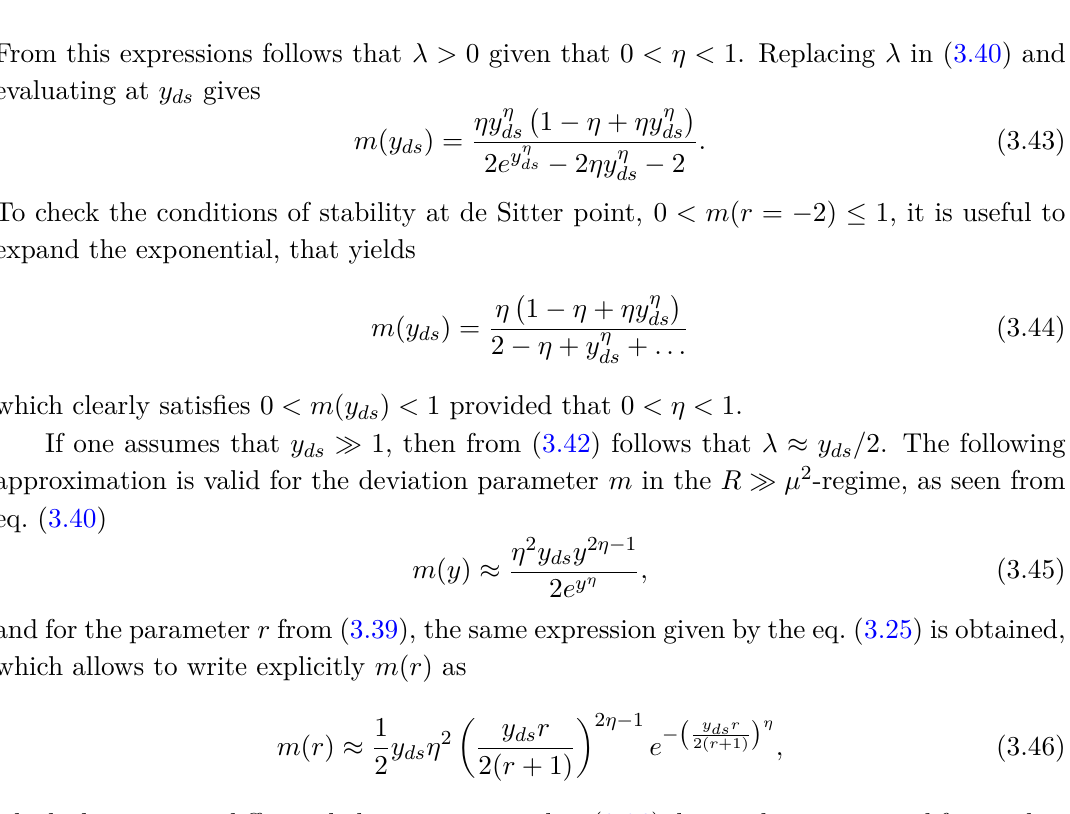
Figure 2 . The evolution of w DE and Ω DE for the model (3.36), assuming Ω m 0 = 0 . 3 . The initial redshift is z i = 6 . 39 for al cases. In all cases the evolution of Ω DE is indistinguishable from that of Λ CDM. Comparing with figure 1 it can be seen that the phantom behavior is more perceptible than in the model